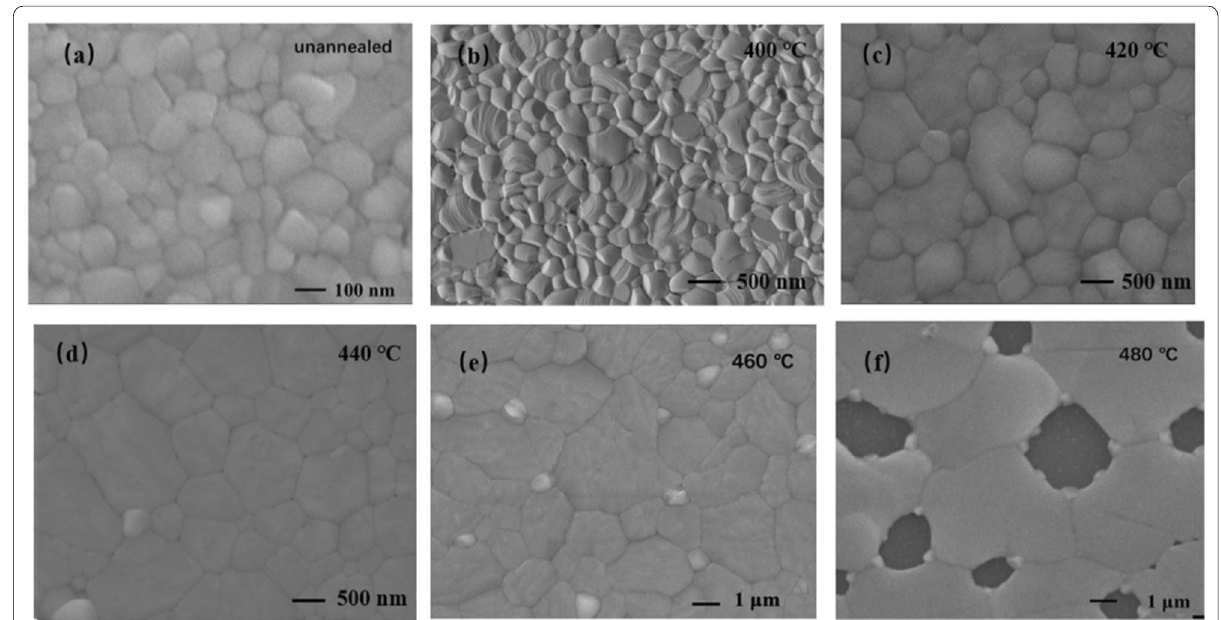
Fig. 6 SEM images of CsPbBr 3 films annealed at different temperatures a unannealed, b 400 ℃ , c 420 ℃ , d 440 ℃ , e 460 ℃ , f 480 ℃